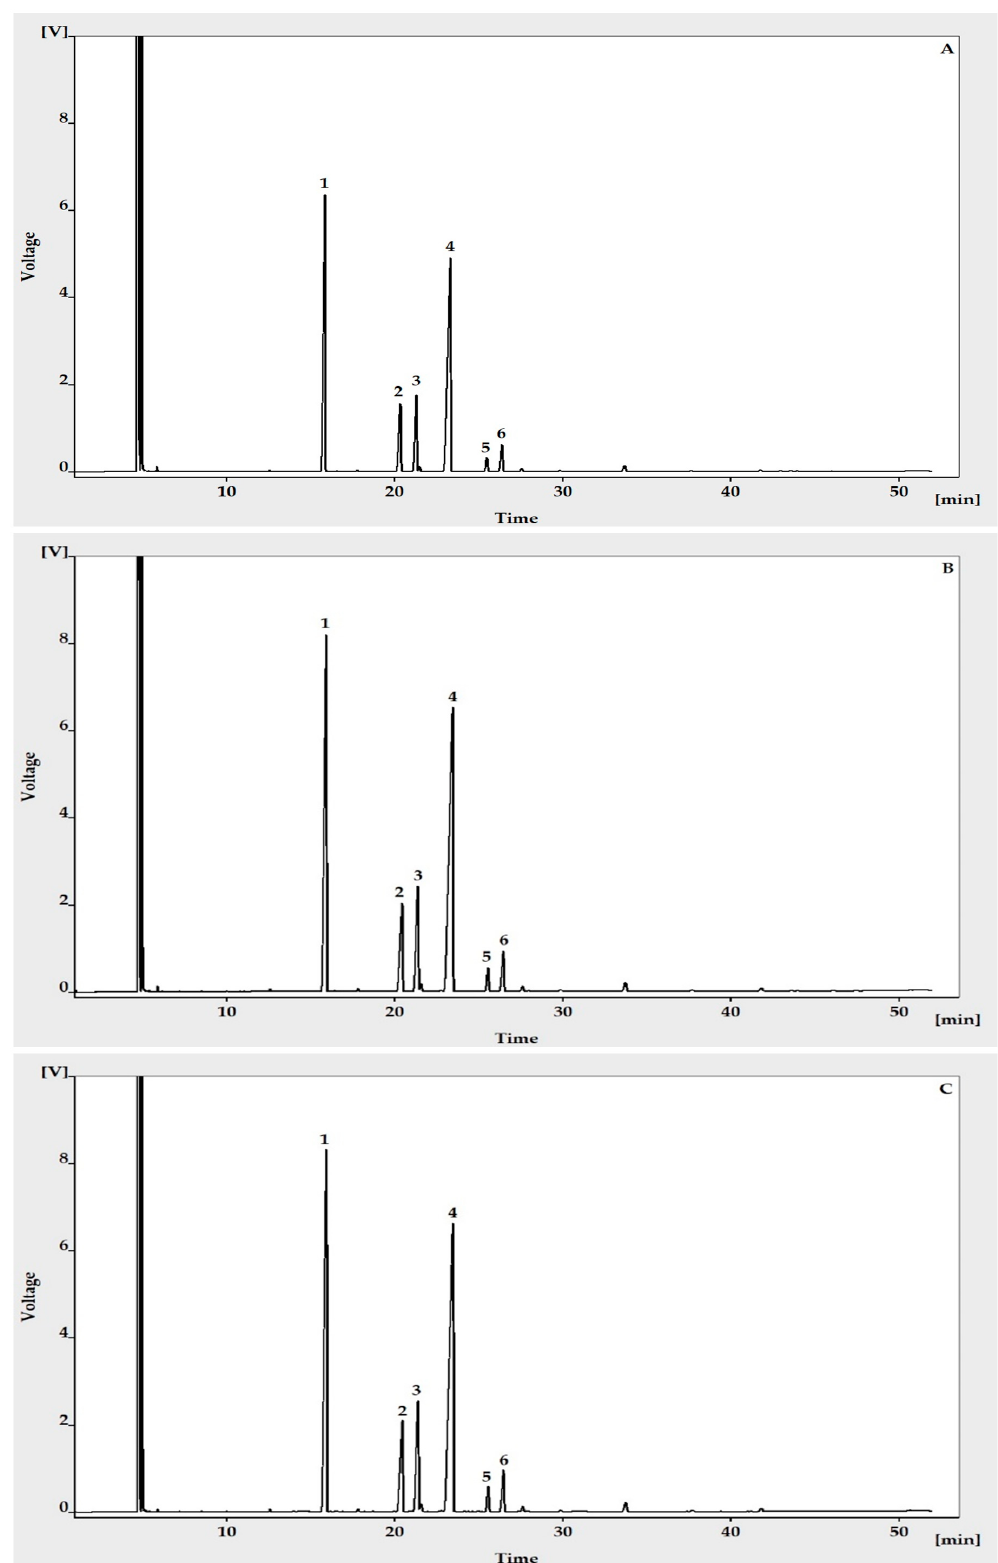
Figure 3. Typical chromatograms of fatty acids profile in Brazilian Coffea arabica beans from different roasting degrees: green ( A ), light roasted ( B ), dark roasted ( C ). Identified fatty acids presented on chromatograms: 1—C16:0, 2—C18:0, 3—C18:1, 4—C18:2, 5—C18:3,